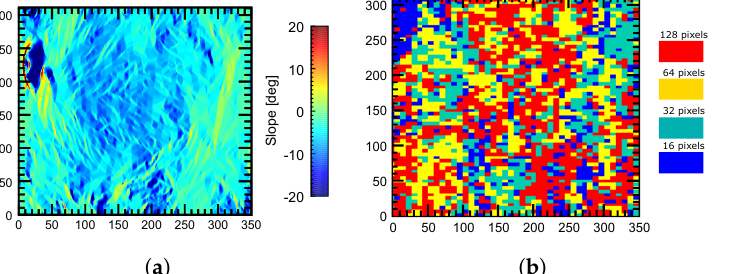
Figure 22. Filtering window sizes providing the best results in a flat area. ( a ) Local terrain slopes in the region of interest. ( b ) Window sizes providing the best filtering results in the region of interest